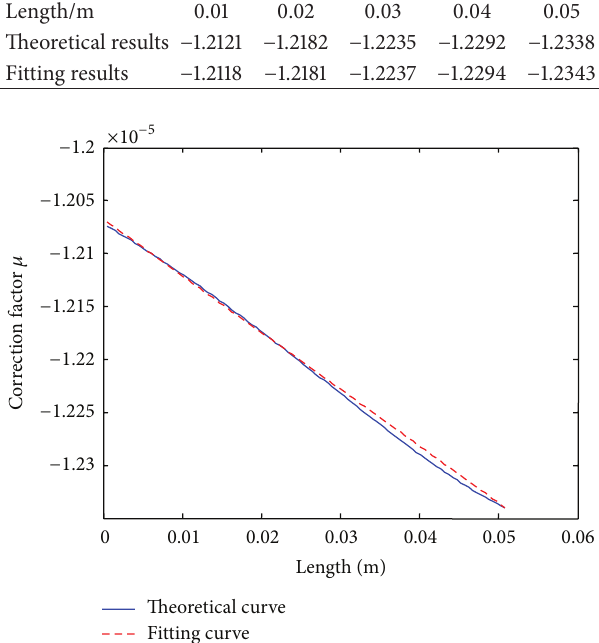
Table 2: Material and geometric parameters. Source: Erturk and Inman, 2009